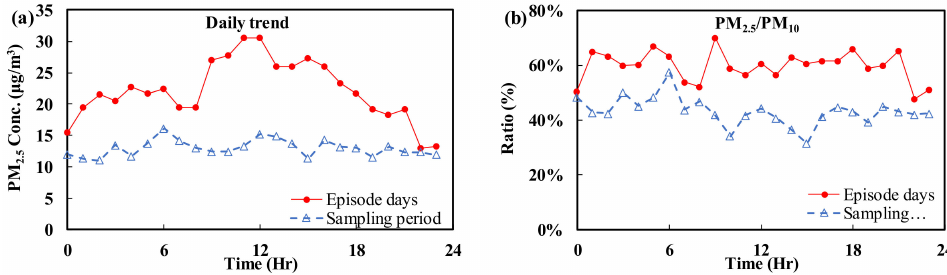
Figure 4. Hourly changes in air quality pollutants on episode days and during the sampling period: ( a ) PM 2.5 ; and ( b ) PM 2.5 /PM 10 . (B) Sulfur oxides (SO 2 , SO 42 − )